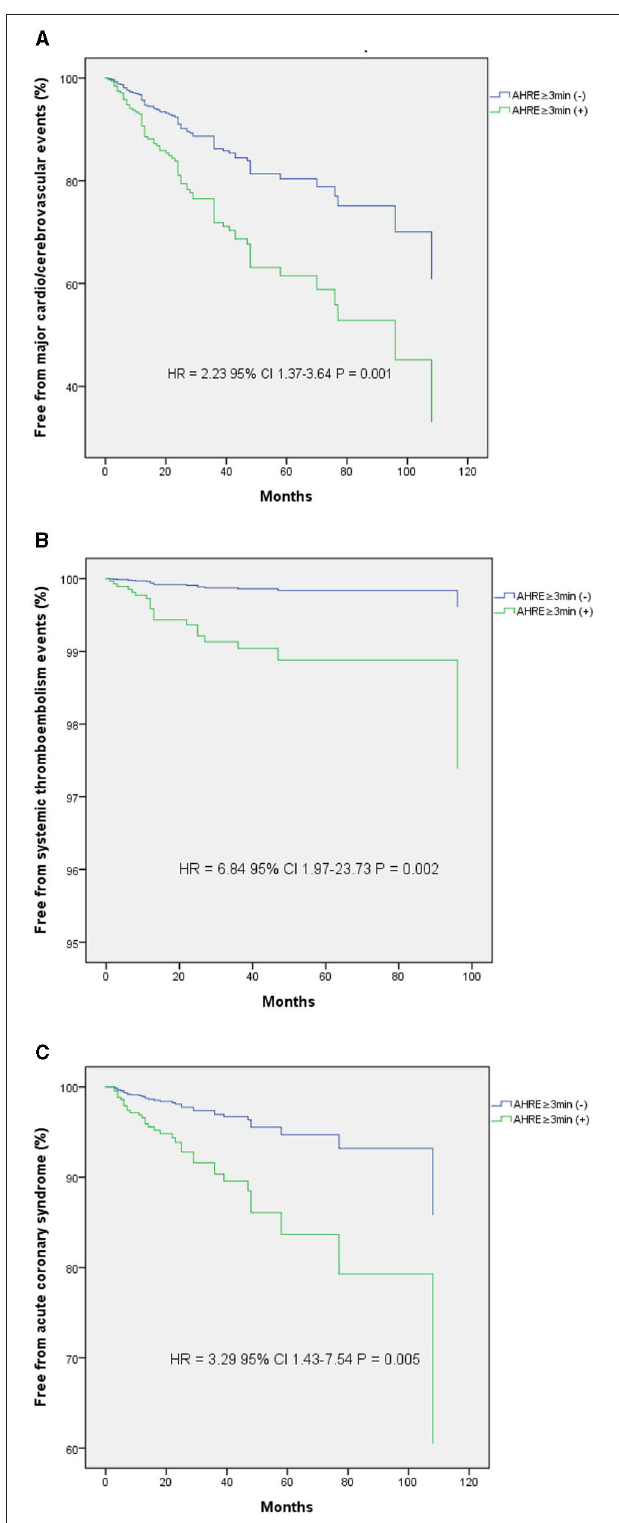
FIGURE 2 | Kaplan-Meier curves depict the accumulative survival rates free from different endpoints regarding AHRE ≥ 3min or not. (A) For major adverse cardio/cerebrovascular events, a significant higher hazard is seen among the